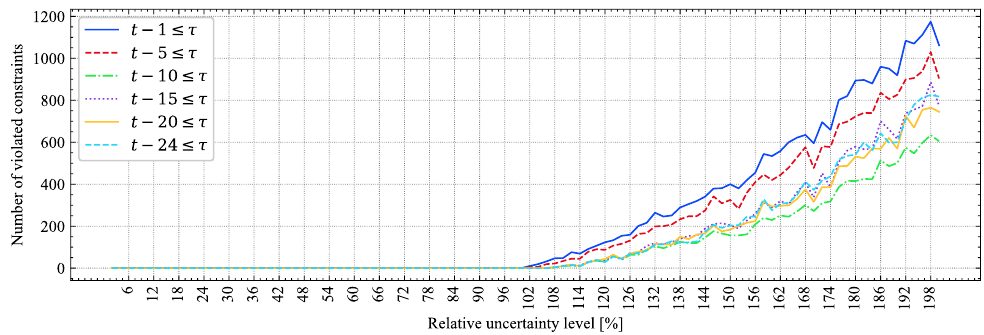
Figure 4. Number of violated constraints vs. materialization of forecast errors, 6-bus system.